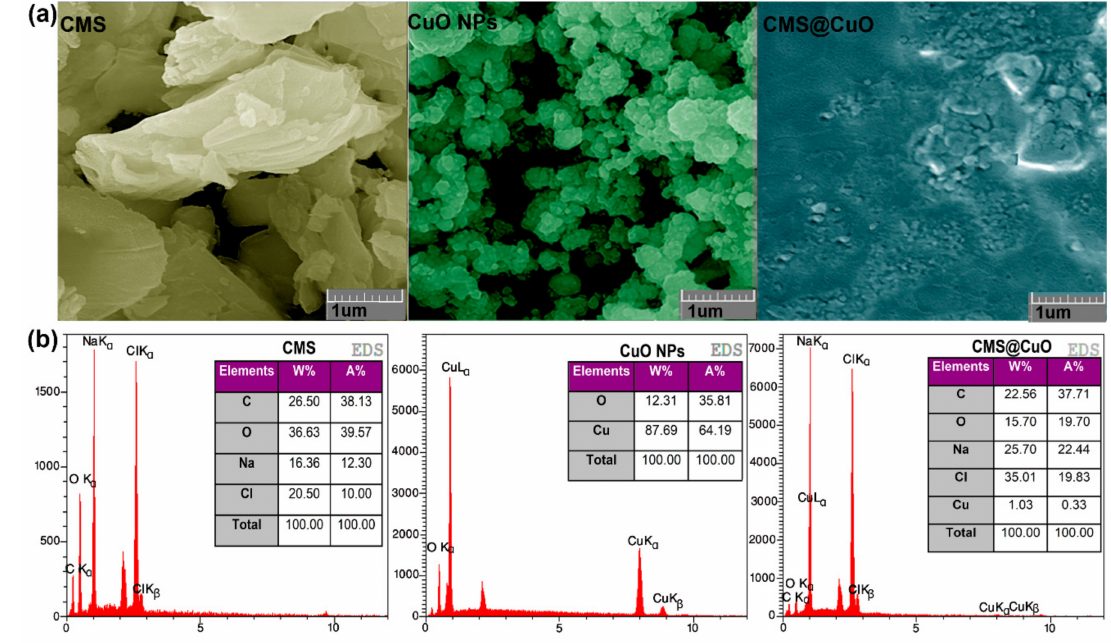
Figure 3. Field emission scanning electron microscopy (FESEM) images ( a ) and energy-dispersive X-ray spectroscopy (EDS) spectra and tabulated data ( b ) of CMS, CuO nanoparticles, and the CMS@2%CuO nanocomposite hydrogel. CMS: carboxymethylated starch; NPs: